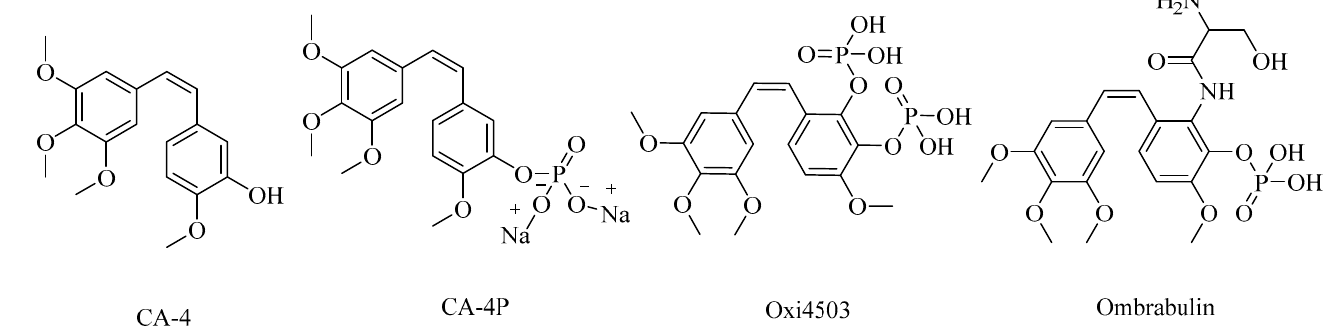
Figure 1. The structures of combretastatin A-4 (CA-4), fosbretabulin (CA-4P), Oxi4503 and Om-